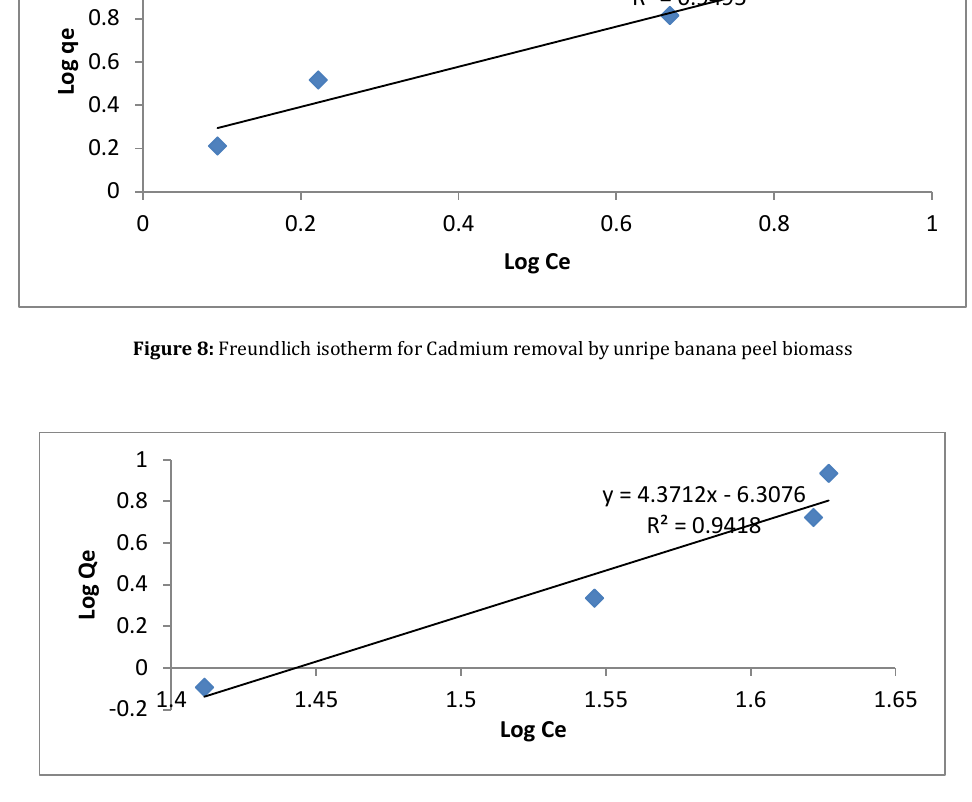
Figure 9: Freundlich isotherm for Chromium removal by banana peel